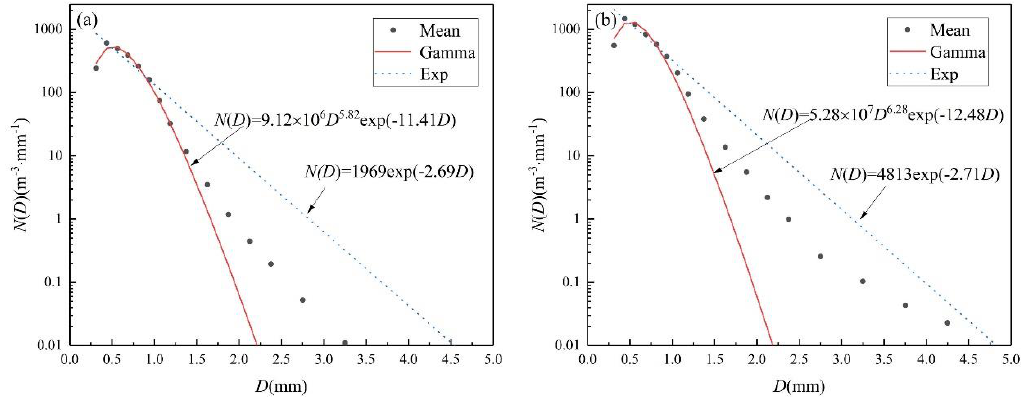
Figure 3. Fitting results of the mean raindrop size distribution for all the precipitation events from ( a ) stratiform precipitation and ( b ) convective precipitation. (Mean: the mean raindrop size distribution; Gamma: the gamma distribution; Exp: the exponential distribution). Table 2. Values of the statistical fit and errors.